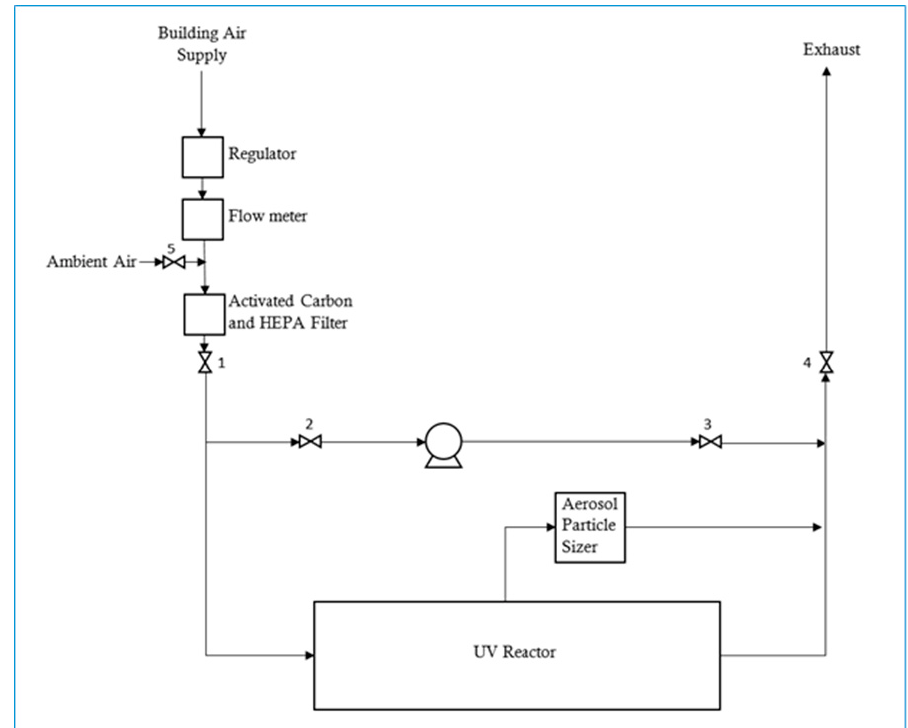
Figure 1. Schematic of the experimental apparatus used to generate secondary organic aerosols (SOA) by ultraviolet (UV) exposure.